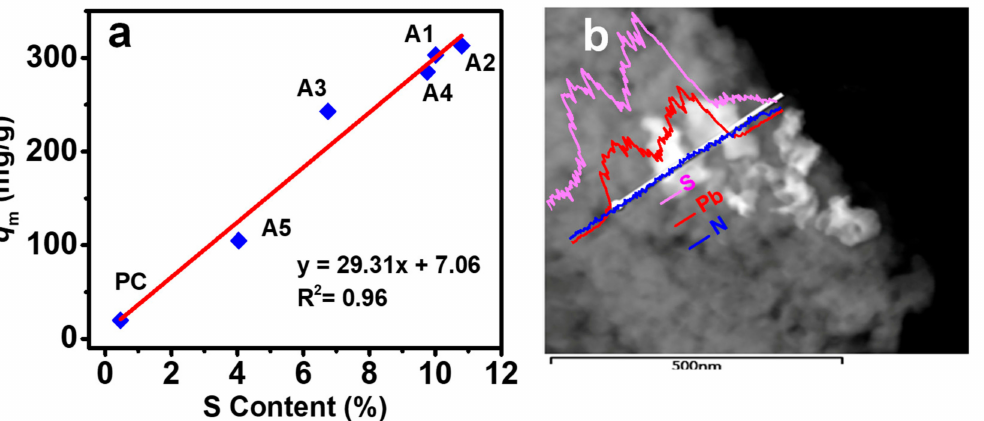
Figure 6. ( a ) Linear correlation between q m and S content of NSC material, ( b ) representative TEM- EDS line profiles of elements in the selected NSC material (A1) after Pb 2+ adsorption. PC: porous carbon material activated with K 2 CO 3 , activation temperature = 700 ◦ C, K 2 CO 3 : biomass mass ratio =